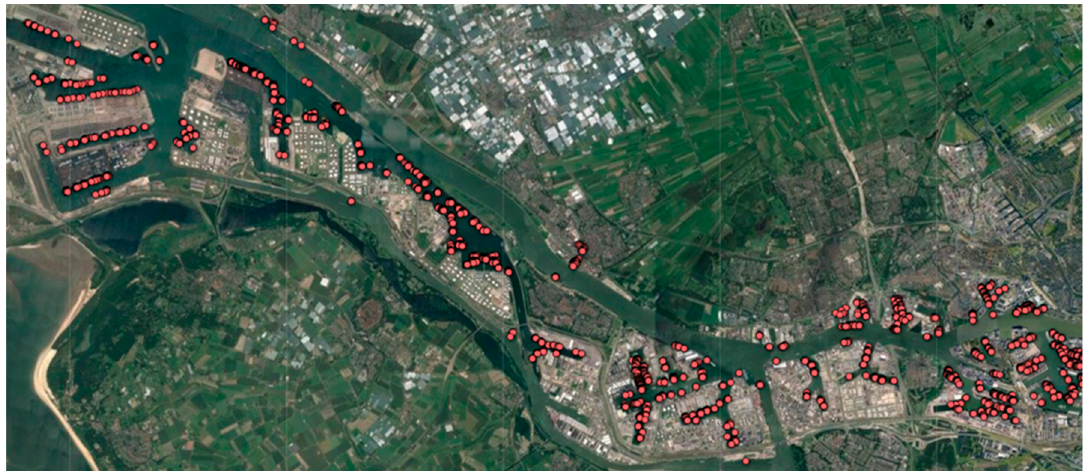
Figure 9. Berth grid cells/OD events detected around Rotterdam.